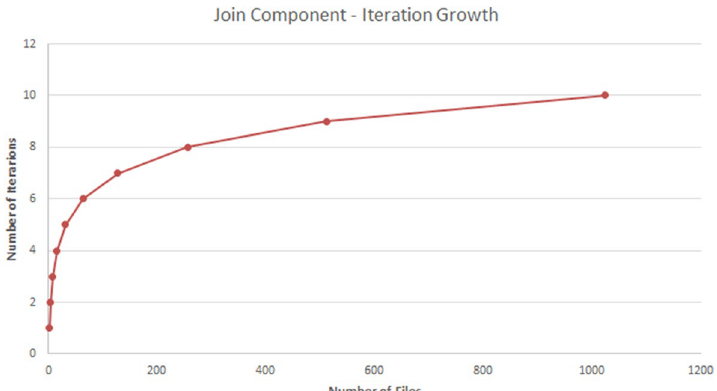
Fig. 4 Join Component – Binary Logarithmic Growth Curve